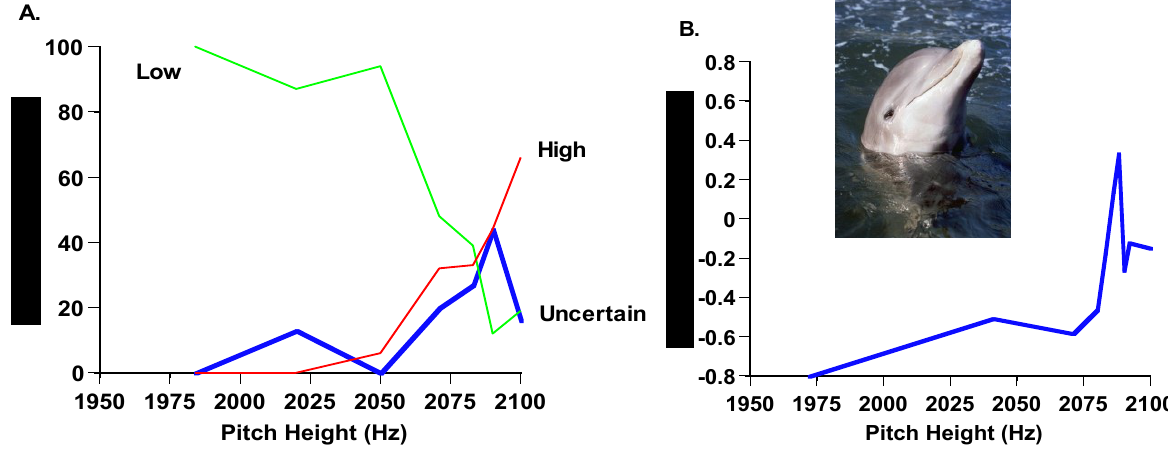
Figure 1. A. Natu a’s performance in a threshold-uncertainty paradigm. He touched a High response when a 2,100 Hz tone sounded. He touched a Low response when any lower tone sounded. The uncertainty response let him decline the trial and move instead into an easy next trial. The pitch of the low tones was varied to find his auditory psychophysical threshold and to study his uncertainty responses in this threshold region of difficult trials. The horizontal axis indicates the frequency of the tone. The green and red lines show the percentage of Low and High responses, respectively, at each pitch level. The blue line shows the percentage of trials receiving the uncertainty response at each pitch level. B. The dolphin’s weighted overall Factor 1 behavior (hesitancy, slowing, wavering ) for different pitch levels. From ‘The Uncertain Response in the Bottlenosed Dolphin ( Tursiops truncatus ),’ by J. D. Smith, J. Schull, J. Strote, K. McGee, R. Egnor, and L. Erb, 1995, Journal of Experimental Psychology: General, 124 , 399, 402. Copyright 1995 by the American Psychological Association. Reprinted with